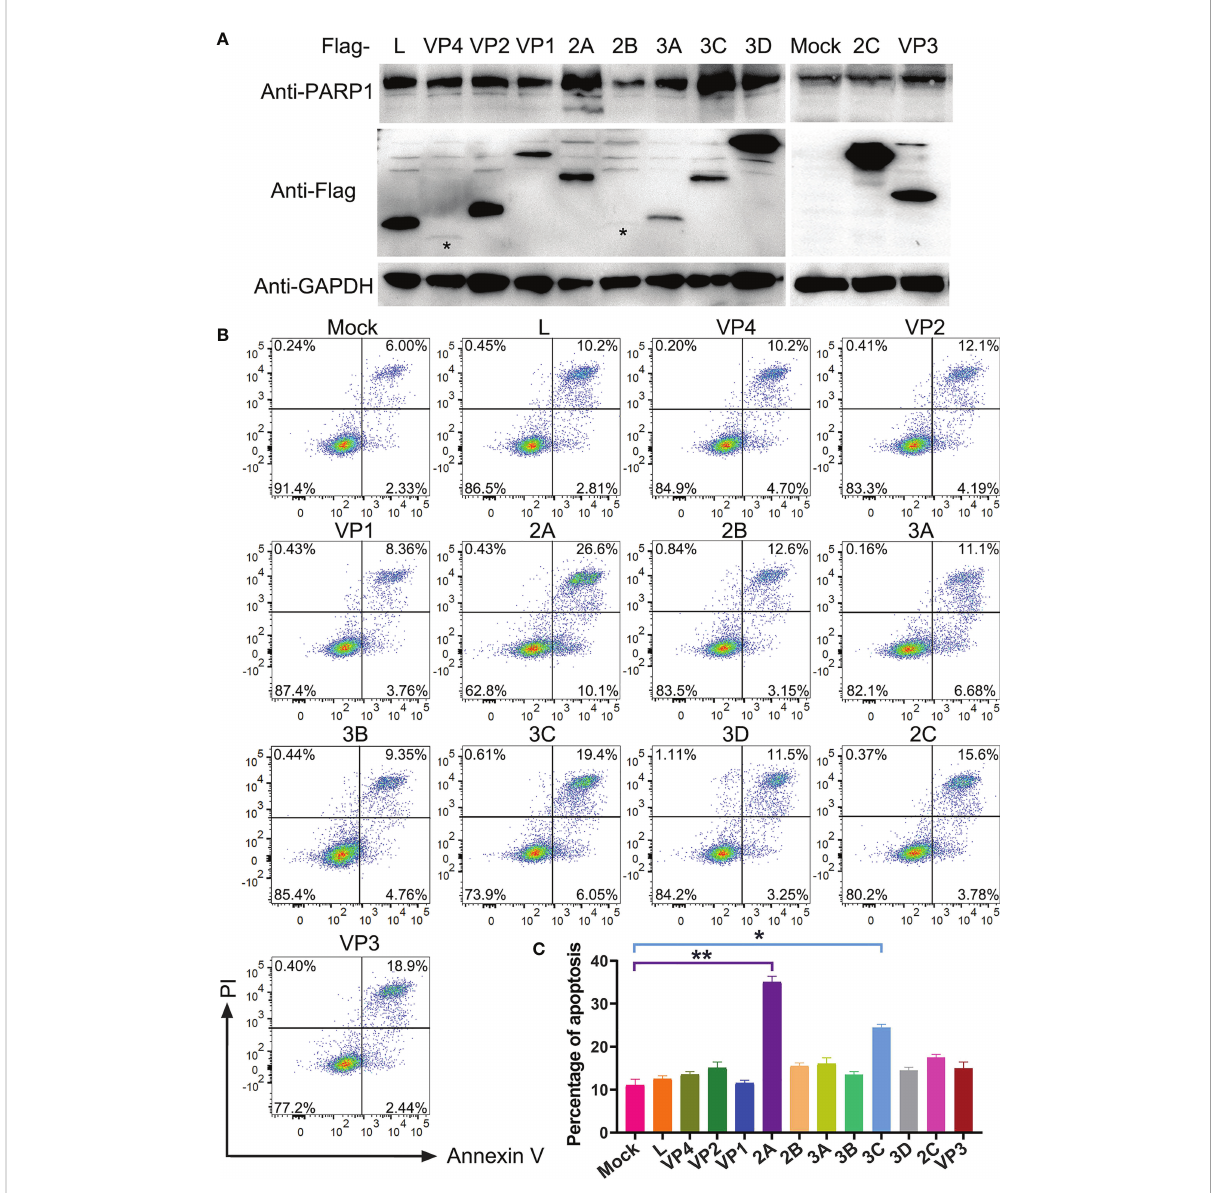
FIGURE 5 Identi fi cation of PSV-encoded proteins that induce apoptosis. (A) The expression plasmids of all PSV-encoded proteins were constructed and respectively transfected into HEK293A for 24 h. Then the cellular lysates were detected by Western blot with antibodies against Flag and PARP1 to detect the expression levels of viral proteins and the PARP1 cleavage. The asteroids indicate VP4, 2B protein bands. (B, C) The HEK293A cells were transfected with the expression plasmids of all PSV-encoded proteins, respectively. After 24 h, the cells were harvested and subjected